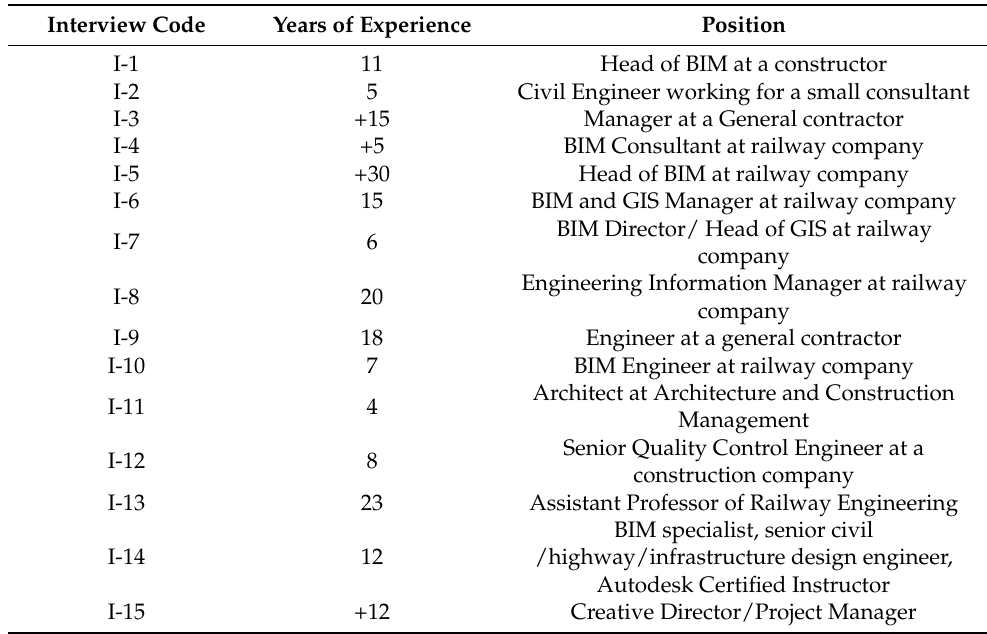
Table 3. Interviewee